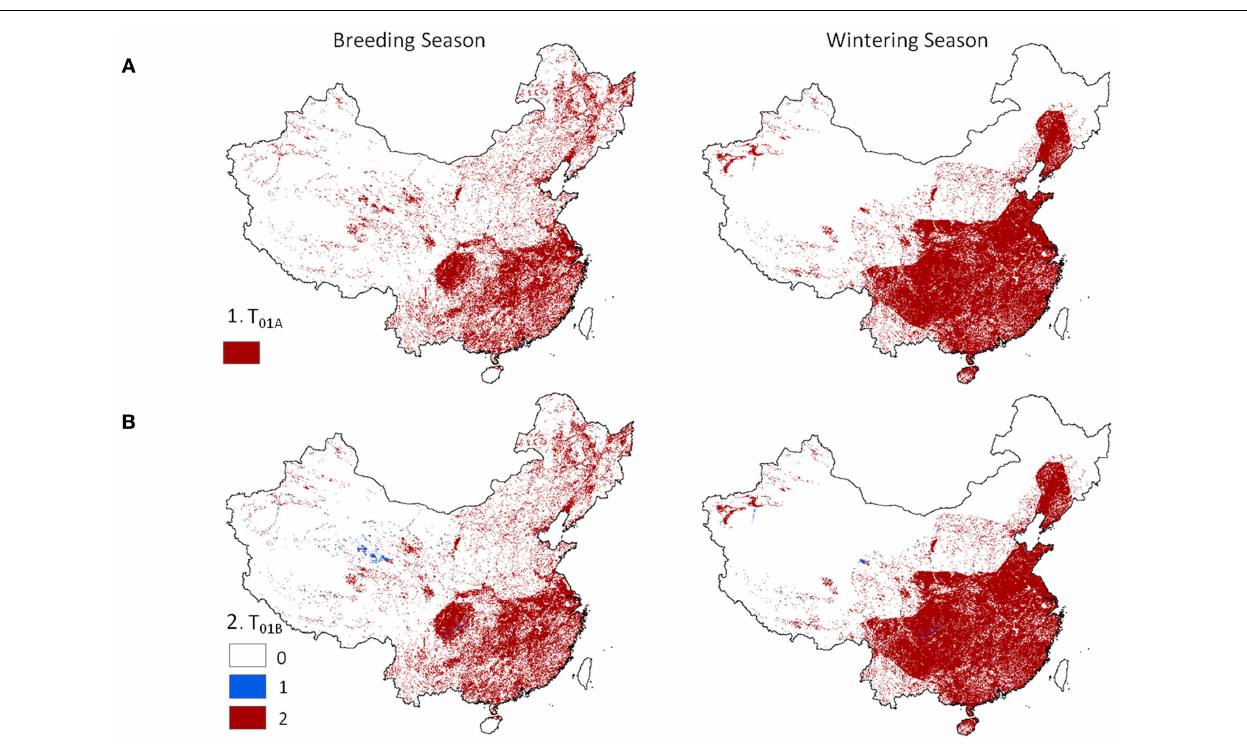
poultry and wild Anatidae are predicted present (Eq. 1), and (B) terrestrial and aquatic poultry are predicted present in combination with wild Anatidae (red) versus presence of one poultry group (blue) with wild Anatidae (Eq.